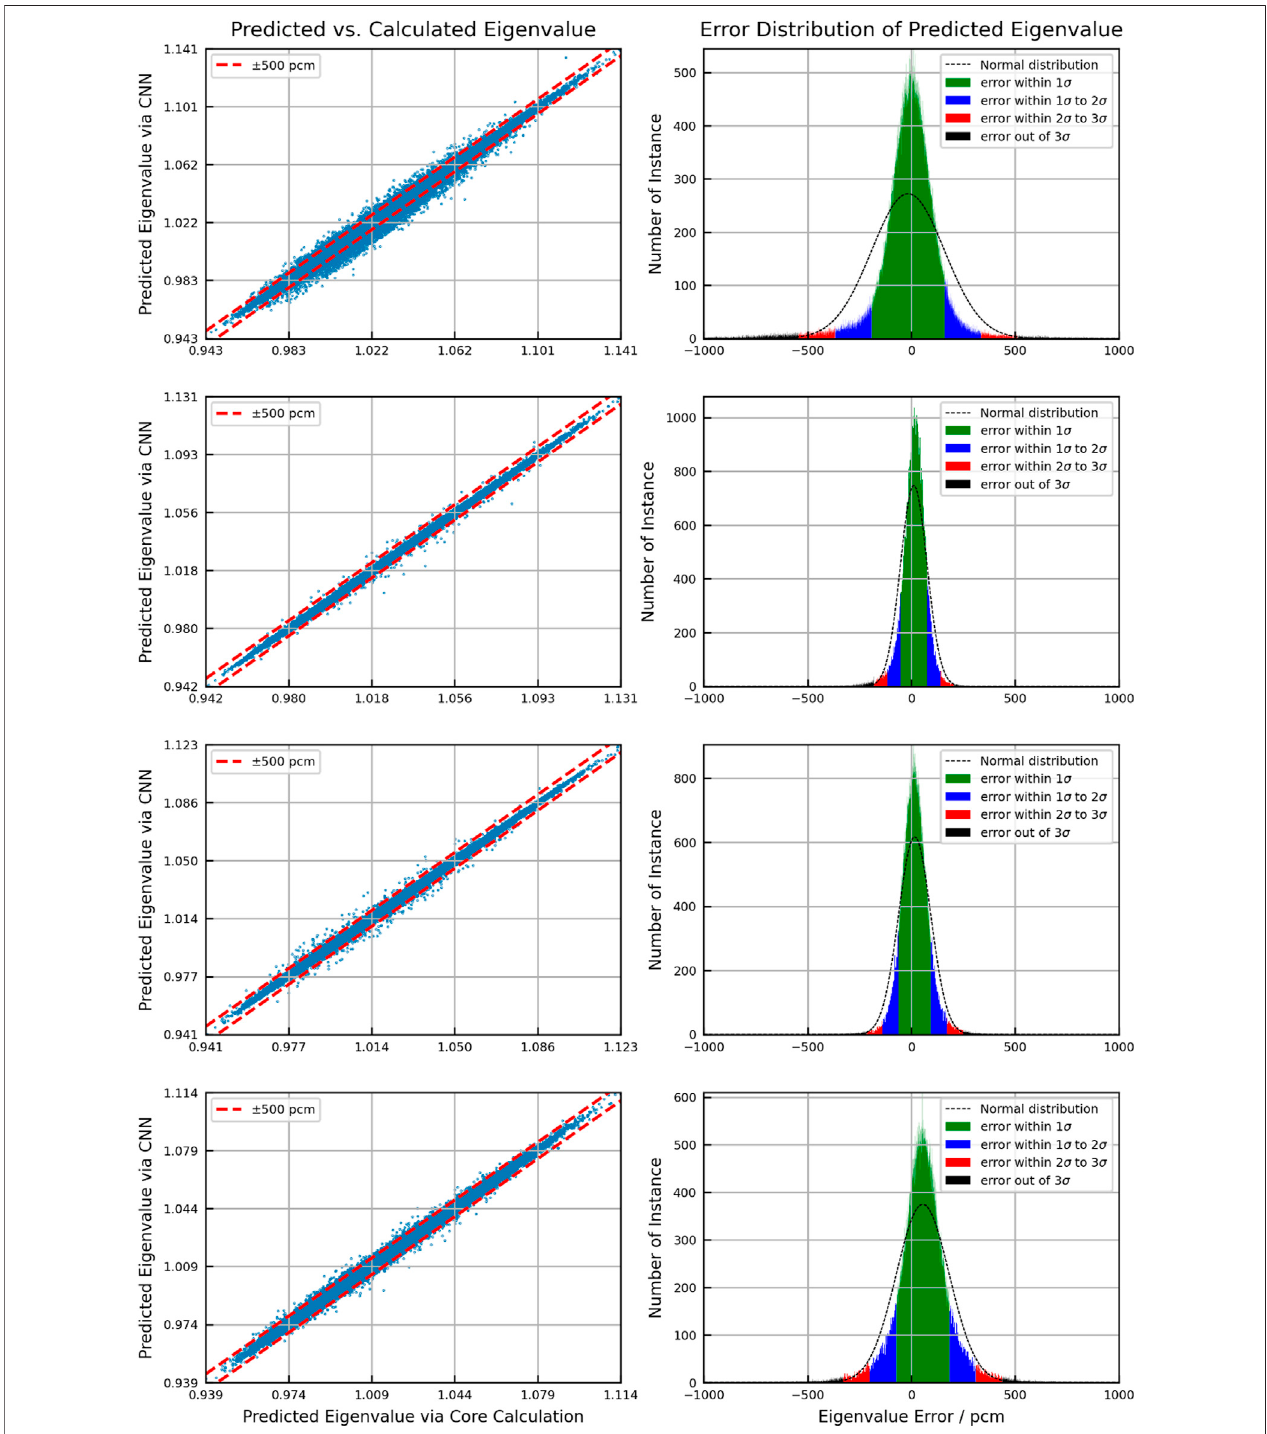
FIGURE 7 | Eigenvalue predicted accuracy of the MOC.